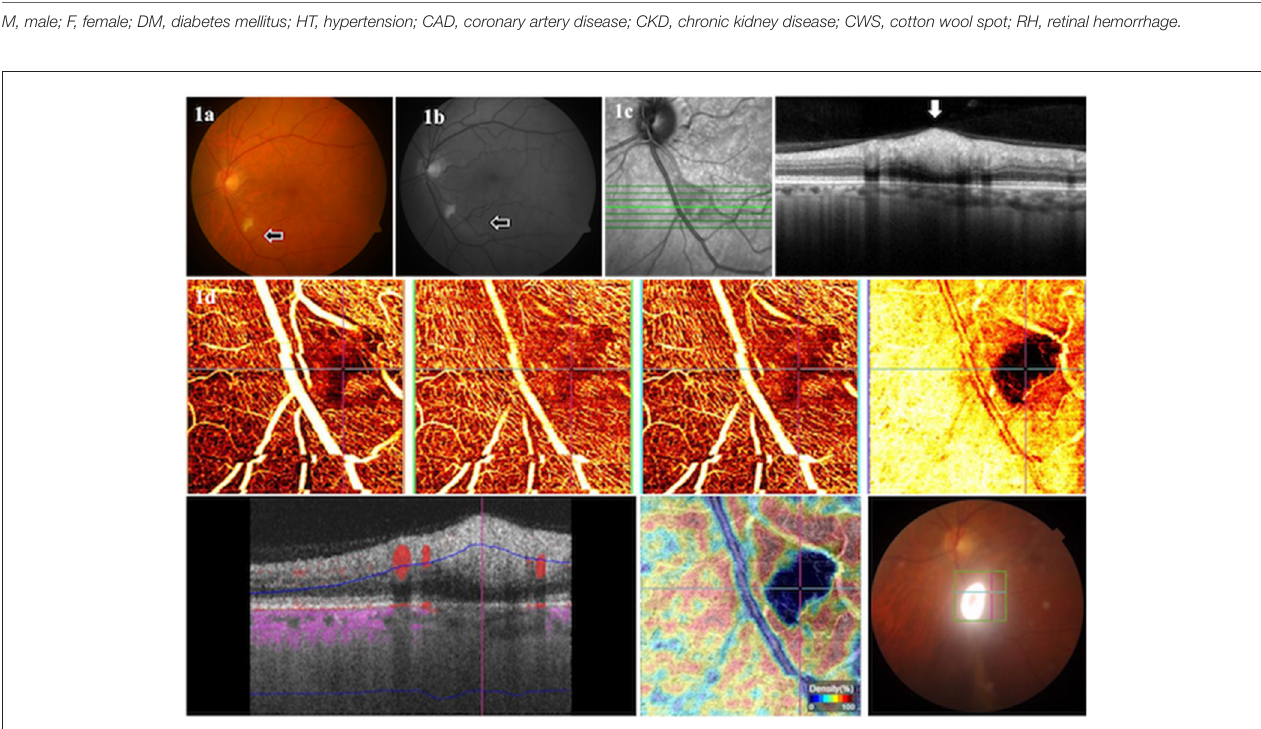
FIGURE 1 | Color (a) and red-free (b) fundus photographs of a 57-year-old male patient in the convalescent phase, examined after 22 days of COVID-19 diagnosis, showing a CWSs in the left eye. The SD-OCT (c) showed retinal nerve fiber layer swelling (arrow) in the region of CWSs. The OCTA (d) showed an absence of signal (arrows) in all layers at the location of